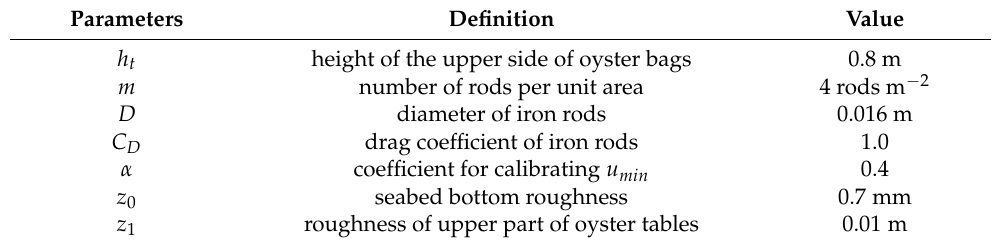
Table 1. Values retained for parameters considered in the computation of the modified Chézy coefficients.